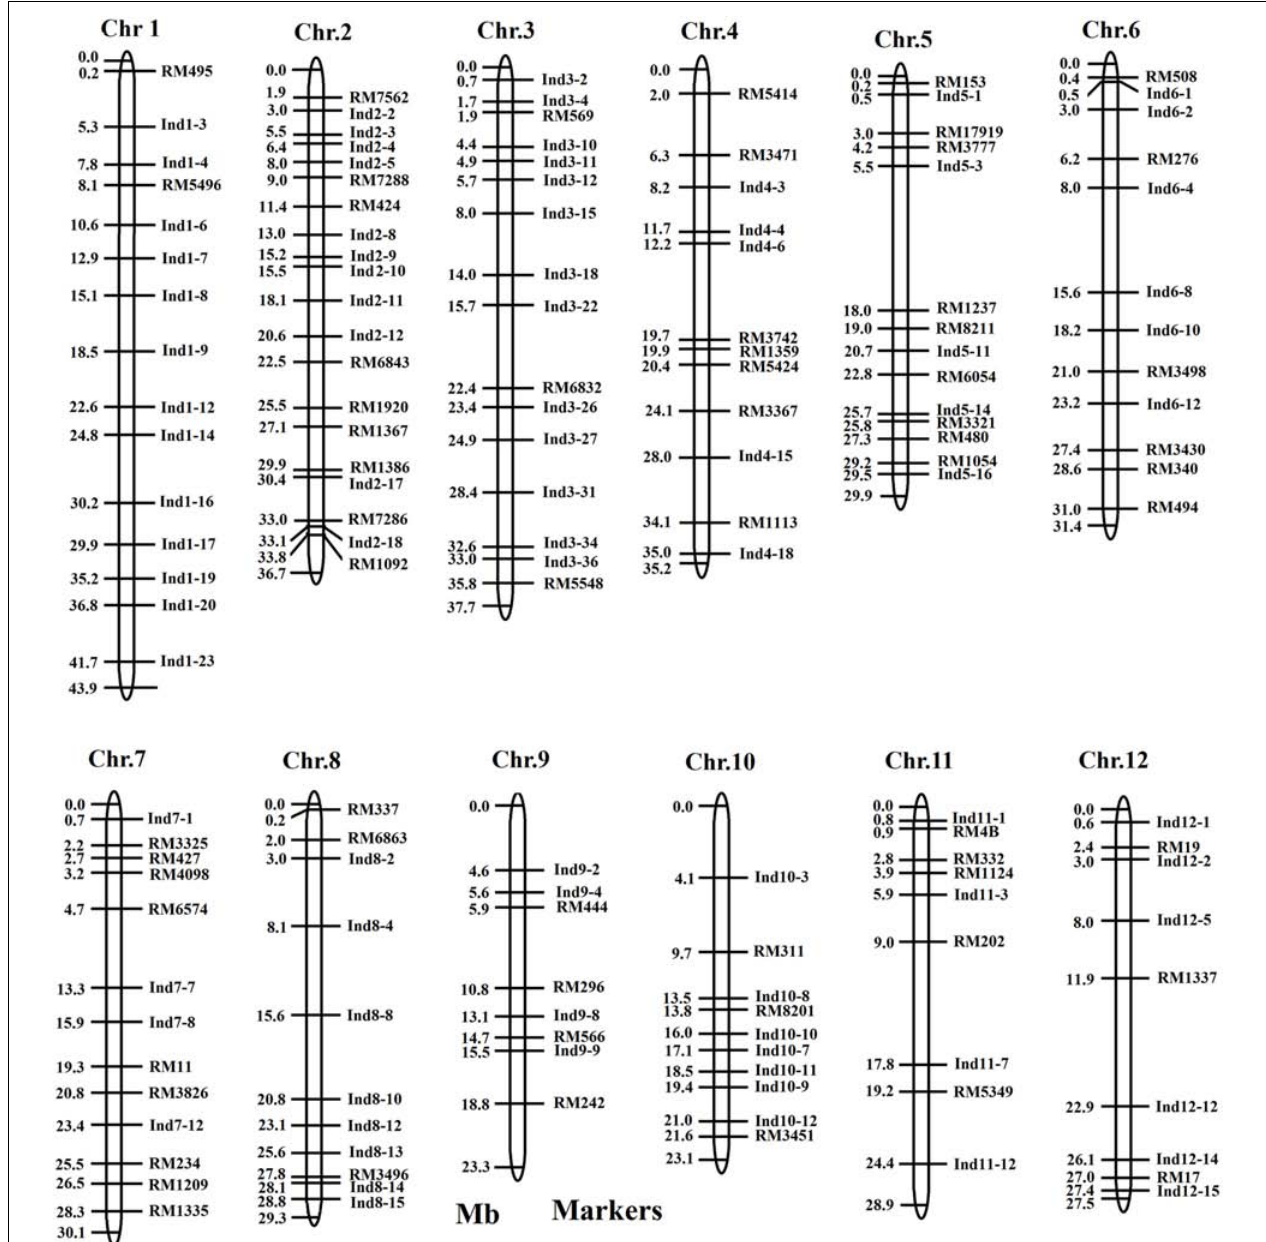
FIGURE 1 | Locations of the 149 polymorphic markers in the rice physical